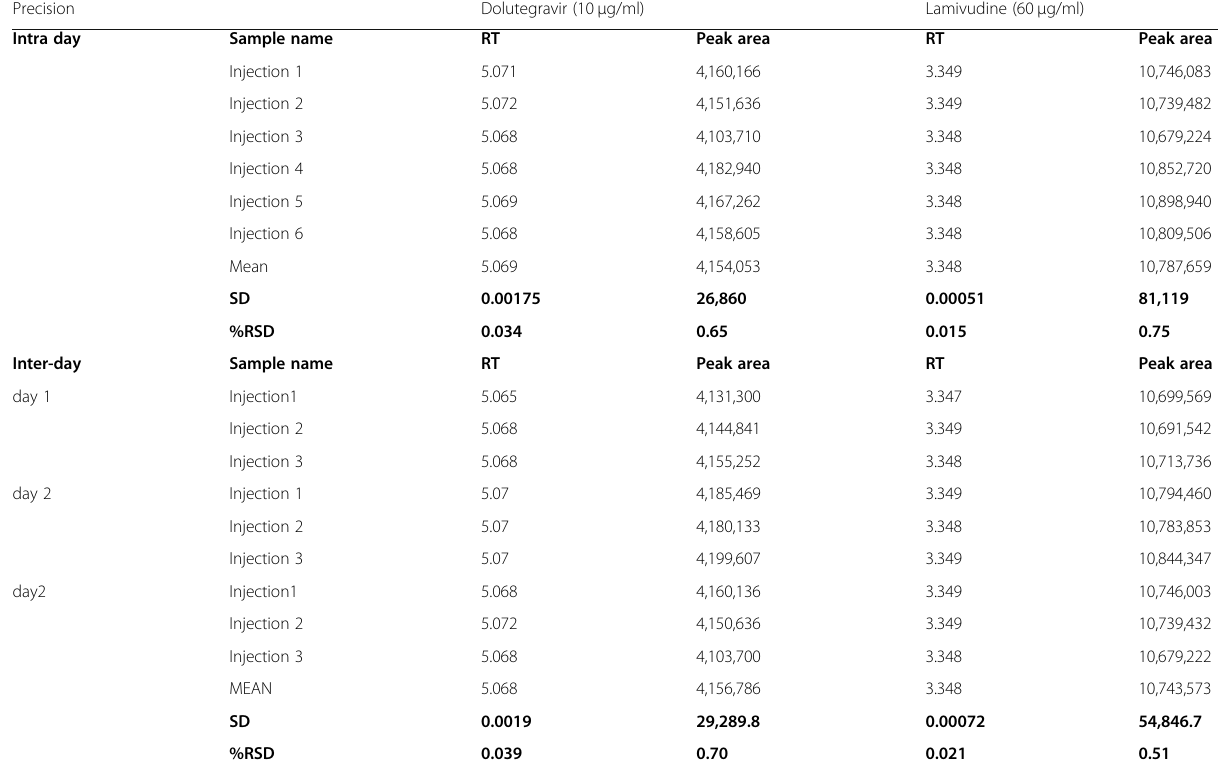
Table 5 Results of intraday and inter-day precision of 100% level solution